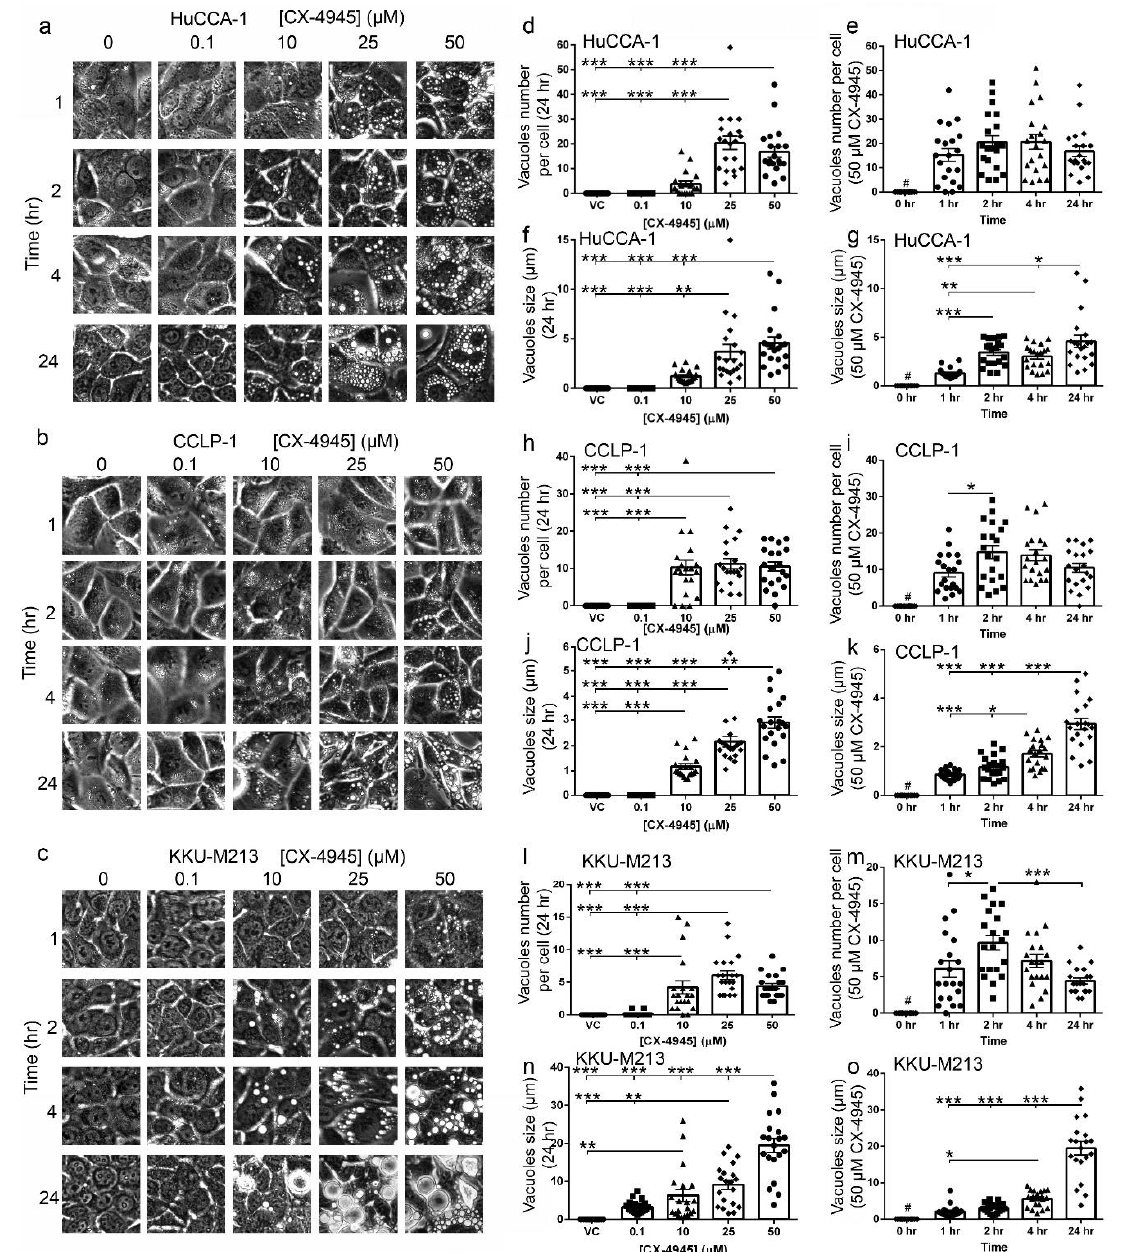
Figure 2. CX-4945 induced vacuolization. ( a – c ) CX-4945 induced intensive vacuolization in CCA cells. CX-4945 induced vacuolization in CCA cell lines in a dose- ( d , f , h , j , l , n ) and time- ( e , g , i , k , m , o ) dependent manner. VC; vehicle control, *; p < 0.05, **; p < 0.01, ***; p < 0.001, #; significantly different from all other groups at p < 0.001. All experiments were performed with at least three biological replicates. Graphs were plotted as mean ± SEM.